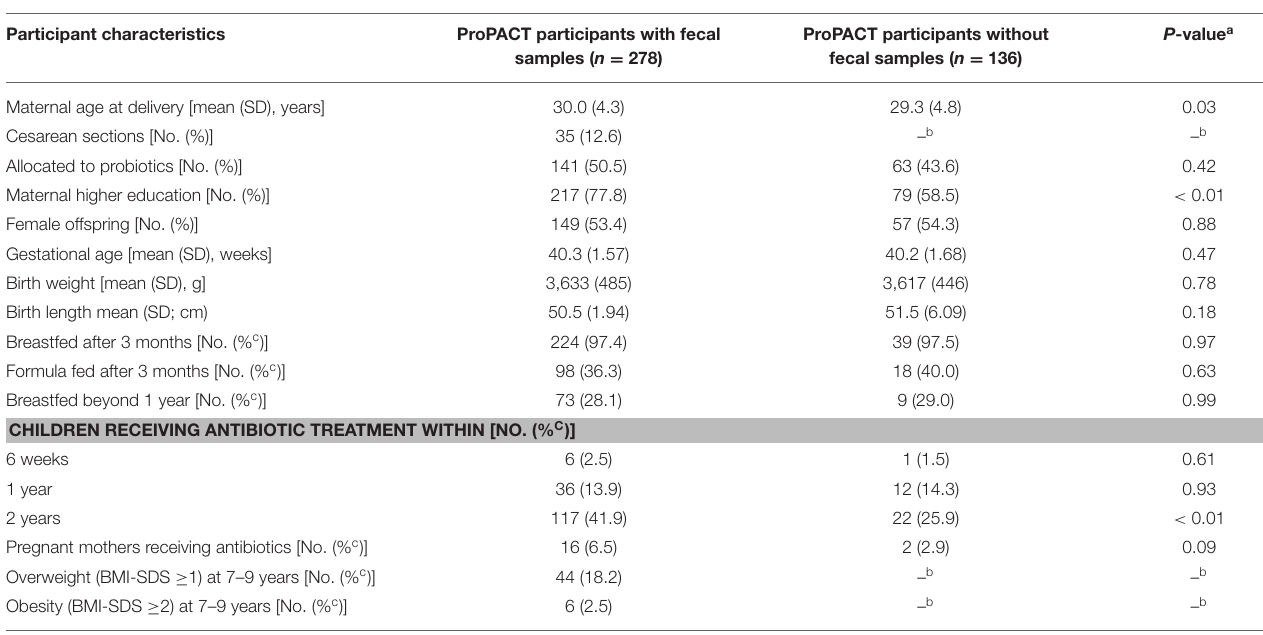
TABLE 2 | Maternal and offspring